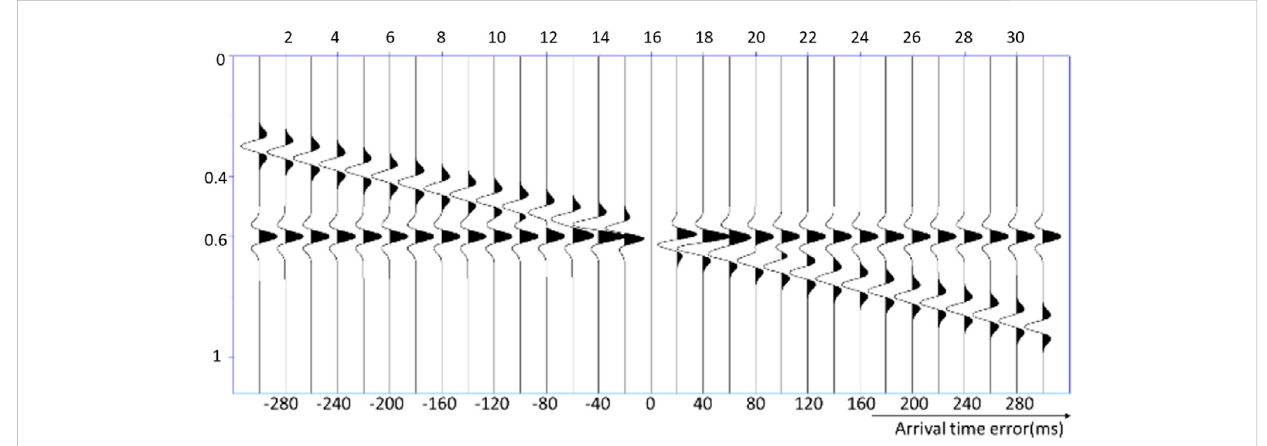
FIGURE 1 Adjoint source. Cycle-skipping issue can be detected when the arrival time is larger than 40 ms.